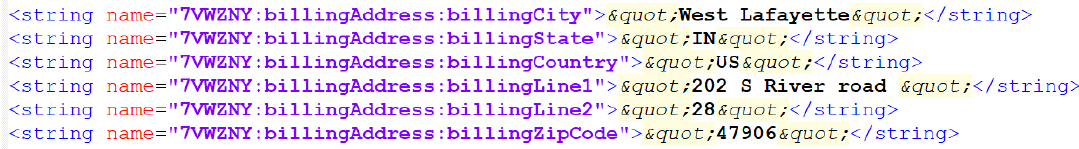
Figure 7. Partial credit card information found as XML data in the same file as billing address information. The data was extracted from the original file to omit irrelevant data surrounding